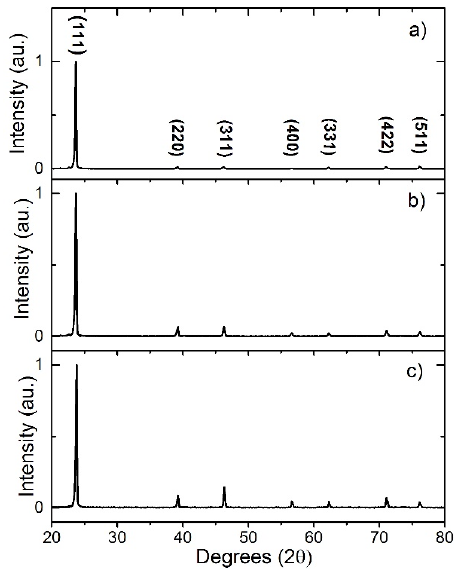
Figure 3. XRD patterns for wire growth on SLG/Mo at ( a ) vacuum and ( b ) 30 Torr; ( c ) Shows XRD pattern of a planar film deposited at 30 Torr on SLG/FTO/Mo. Table 1. Texture coefficients ( C hkl ) and standard deviation ( σ ) calculated for each of the samples shown in Figure 3.